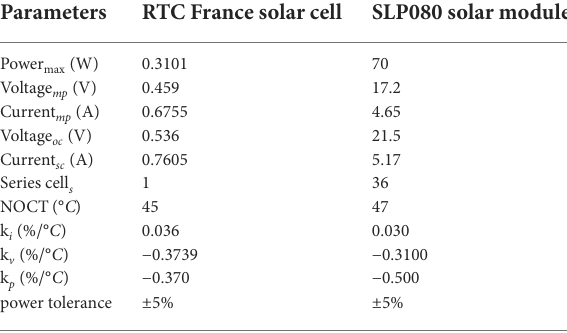
TABLE 1 The manufacture data of the considered PV cell/module.